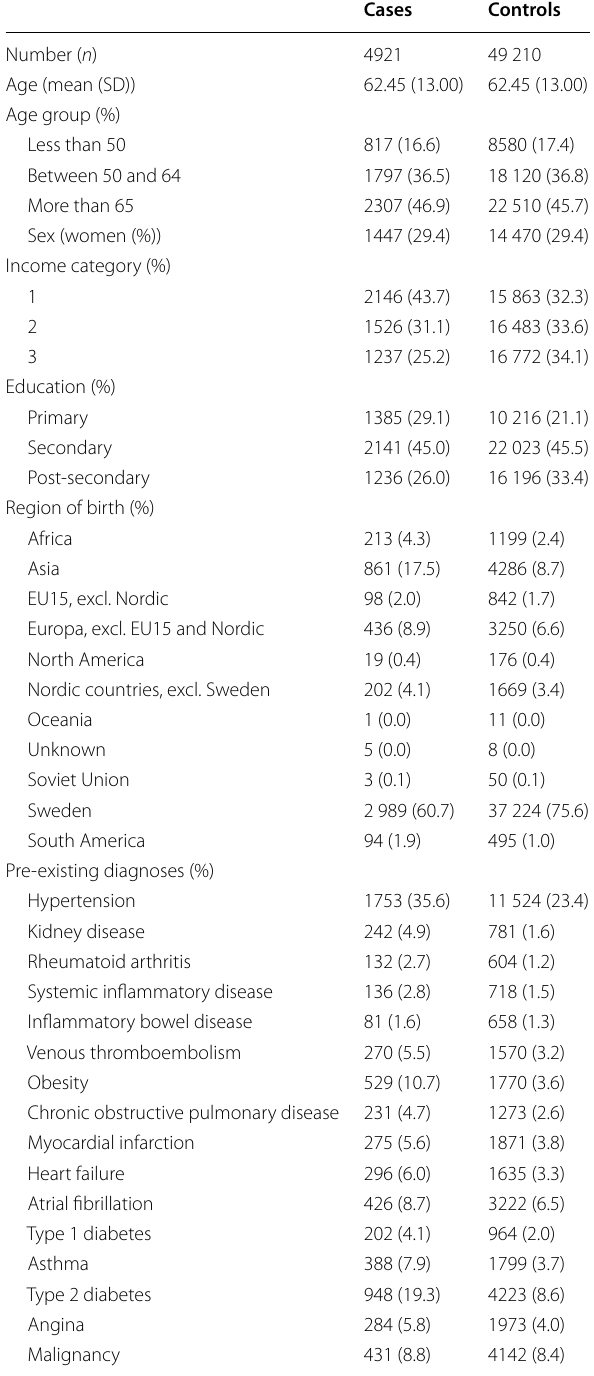
Table 1 General characteristics of cases and population-based controls